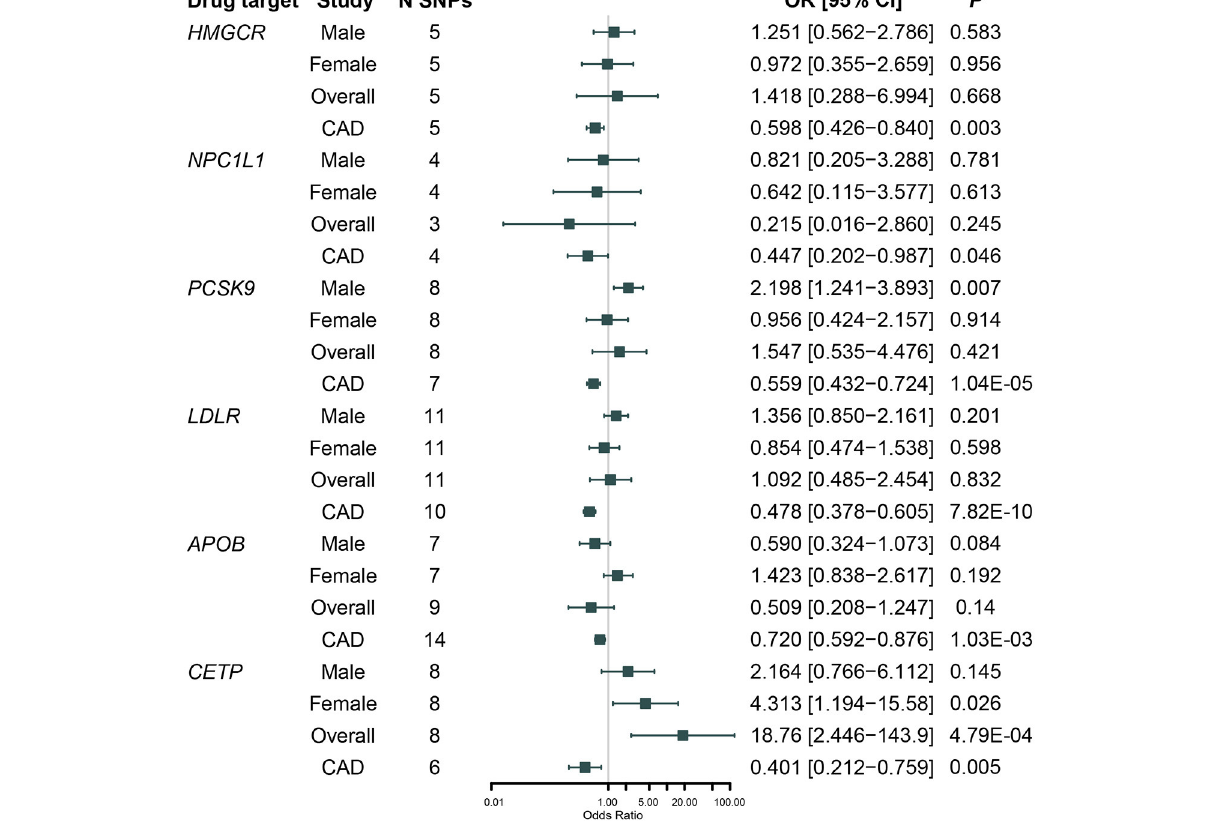
Frontiers in Nutrition |